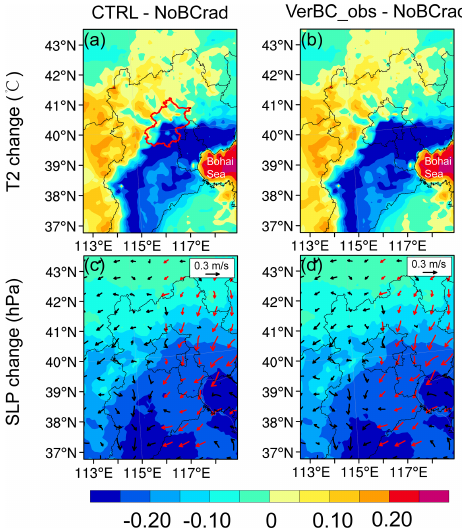
Figure 8. The changes in T 2, SLP, and wind at 10m induced by BC DRE with the original ( a, c ; CTRL minus NoBCrad) and modified vertical profiles ( b, d ; VerBC_obs minus NoBCrad) averaged over the period of 12:00–18:00LT of the two haze events, respectively. (c–d) The northeasterlies in the east of BTH are denoted in